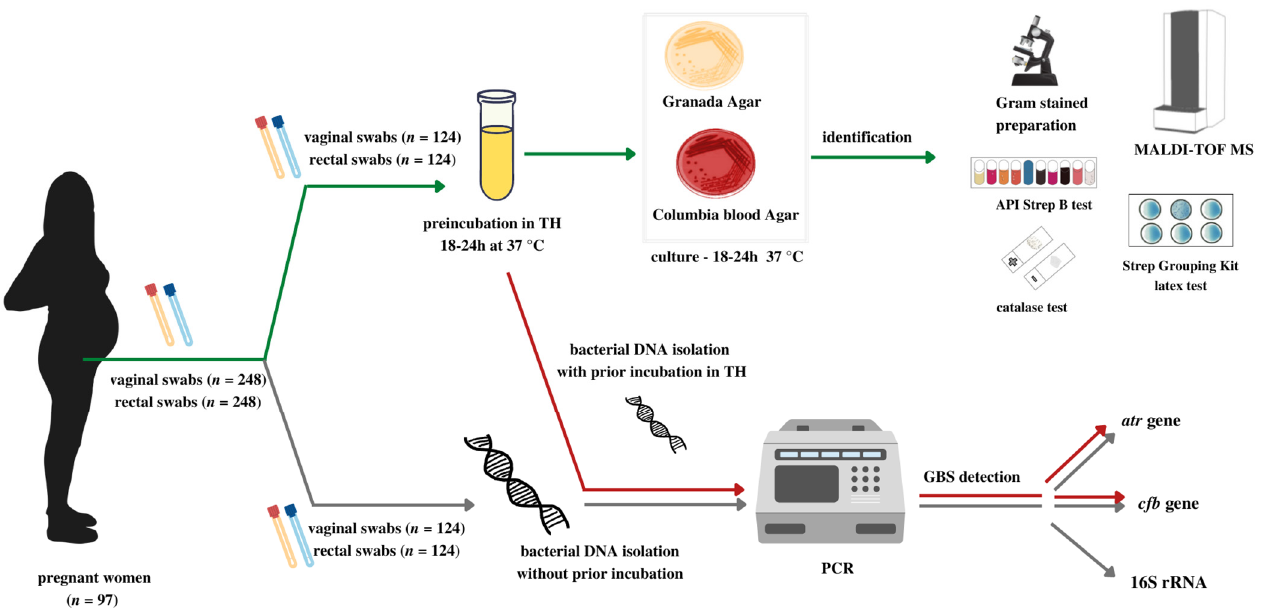
Figure 1. The scheme shows the course of the research and the methods used for GBS–carriage diagnostics in the studied samples. Green and red colors are, respectively, the classical and molecular course of diagnostics in accordance with ASM recommendations [1], taking into account preincubation in liquid TH medium with colistin and nalidixic acid. Gray color is the course of GBS identification using molecular methods, without the preincubation step.